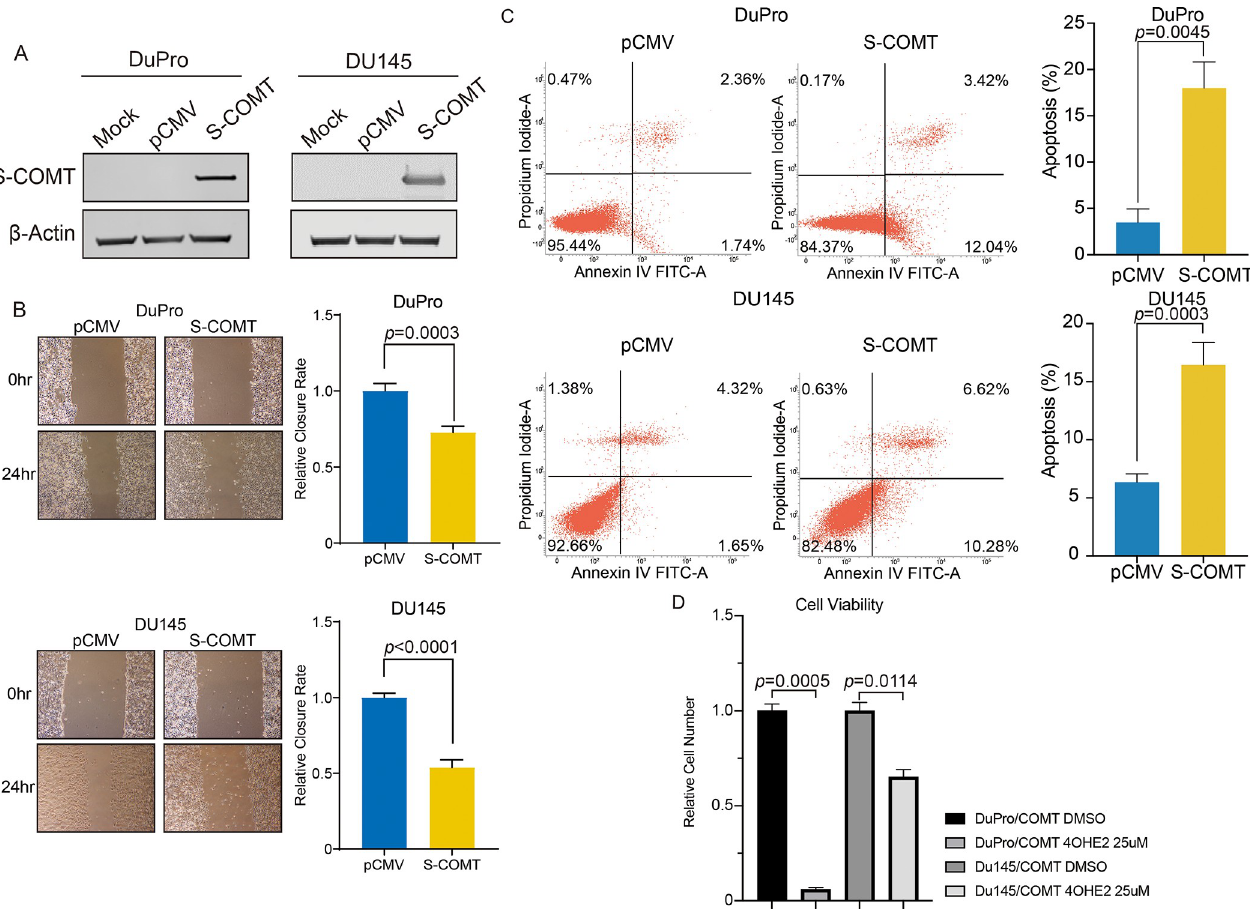
Fig 2. Re-expression and tumor suppressive effect of COMT on cells. (A) Ectopic expression of COMT. DuPro cells stably transfected and DU145 cells transiently transfected with either COMT or empty vector (pCMV) along with mock were grown for 48 hours and underwent western analyses. β -actin was used as loading control. (B) Cell migration as measured by wound healing assay. CytoSelect Wound Healing assay was used, and closure measured after 24 hours. Left : Representative images of wound healing assay are shown. Right : Migration expressed as relative closure rate of wound normalized to pCMV. (C) COMT expression upregulates apoptosis. Stable COMT-expressing DuPro and transiently COMT-expressing DU145 cells along with vector controls were grown for 72 hours and apoptosis was measured by flow cytometric analyses. Left : Representative quadrant dot plot showing cell population in early (bottom right quadrant) and late (top right quadrant) apoptotic states for each treatment. Right : Total apoptosis %. (D) COMT expression attenuates 4-hydroxyestradiol stimulated proliferation. Stable COMT-expressing DuPro and transient COMT expressing DU145 were treated with 4-hydroxyestradiol at a dosage of 25 μ M for 24 hours, and cell proliferation was analyzed by the MTS proliferation assay. Results are normalized to DMSO control. Data are presented as mean ± SD. All p -values are based on paired t-test.